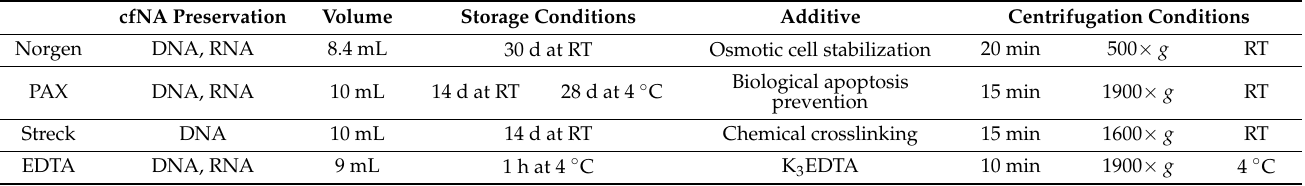
Table 1. Characteristics of different blood preservation tubes and plasma isolation